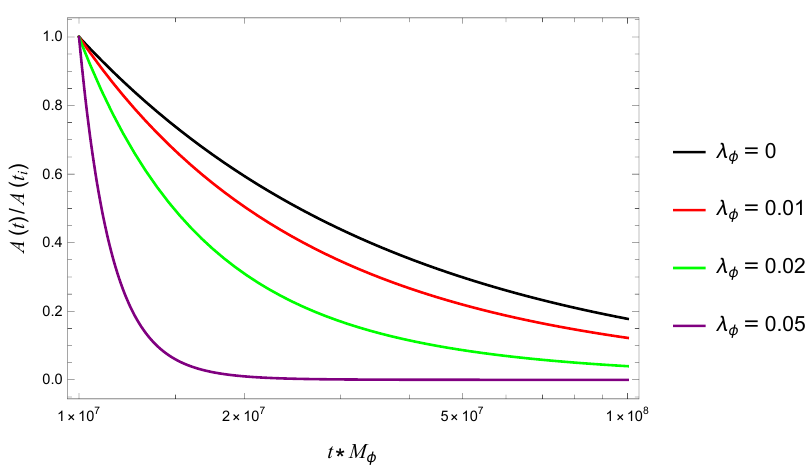
Figure 12 . Numerical solutions of the condensate equation (4.5) with M pl /M φ = 10 9 and g ∗ = 100 . The initial condition A ( t i ) /M φ = 1 is set at t i M φ = 10 7 such that the initial temperature T i ≈ M φ . A larger λ φ corresponds to a larger Ω and the energy transfer from the condensate to the produced particles is more efficient.